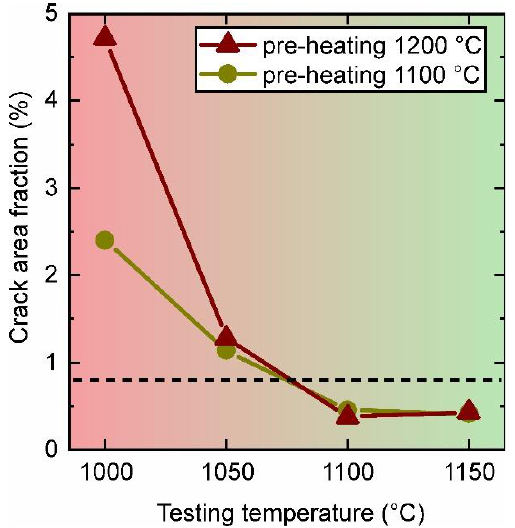
Figure 5. Crack area fraction as a function of the testing temperature after deformation at a strain rate of 10 −3 s −1 and total deformation strain of 50%. The dashed line indicates a threshold value for the qualitative characterization of the samples. Below this threshold value no cracks could be ob- served visually at the surface inspection.